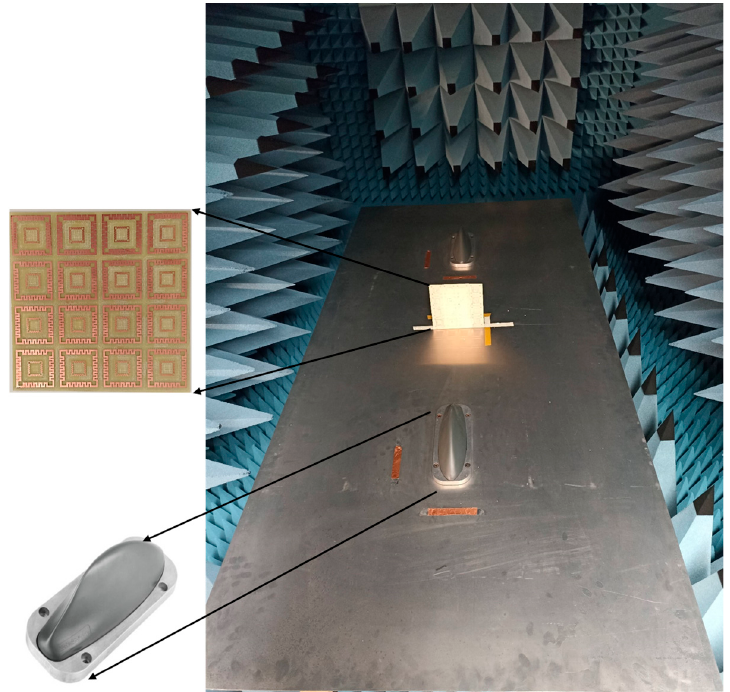
Figure 10. Experimental setup for the FSS structure measurement in an anechoic chamber.